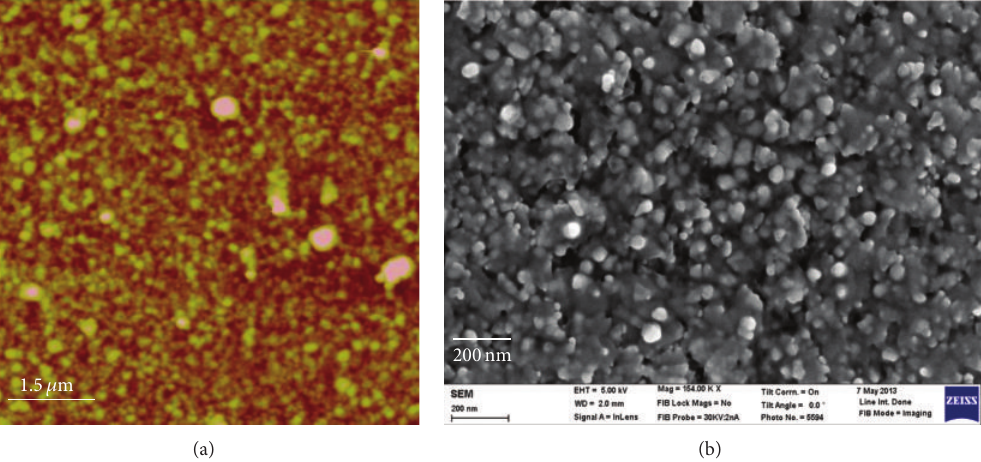
Figure 3: (a) Surface topography of Ag:TiO 2 nanocomposite thin films recorded by AFM in contact mode recorded in scan area 7.5 𝜇 m ×